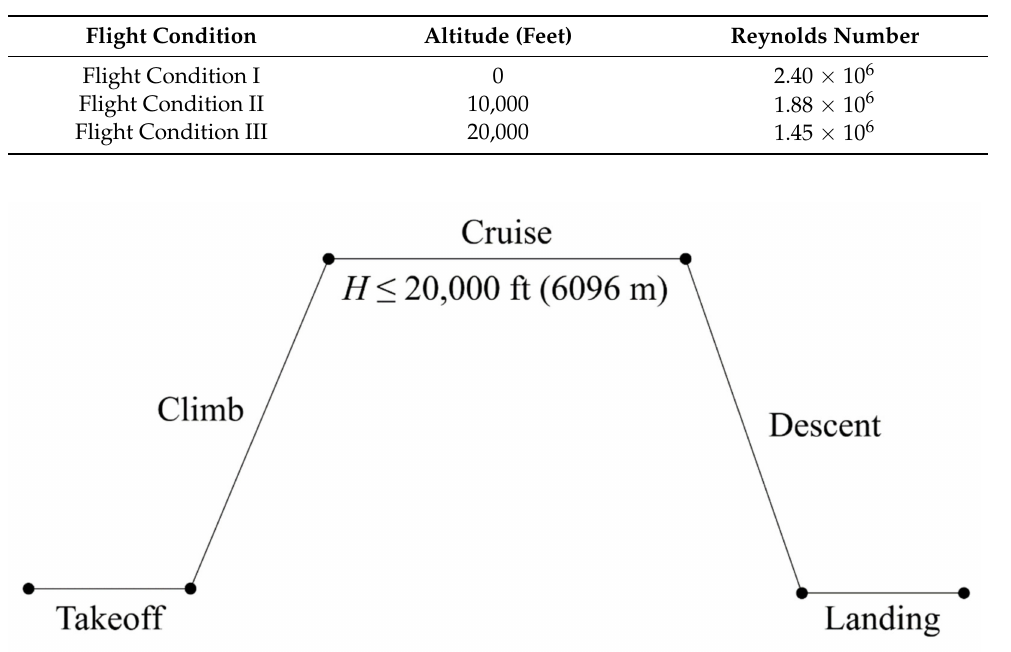
Table 5. Operating conditions for design problem of UAS-S45 at the airspeed of 34 m/s.